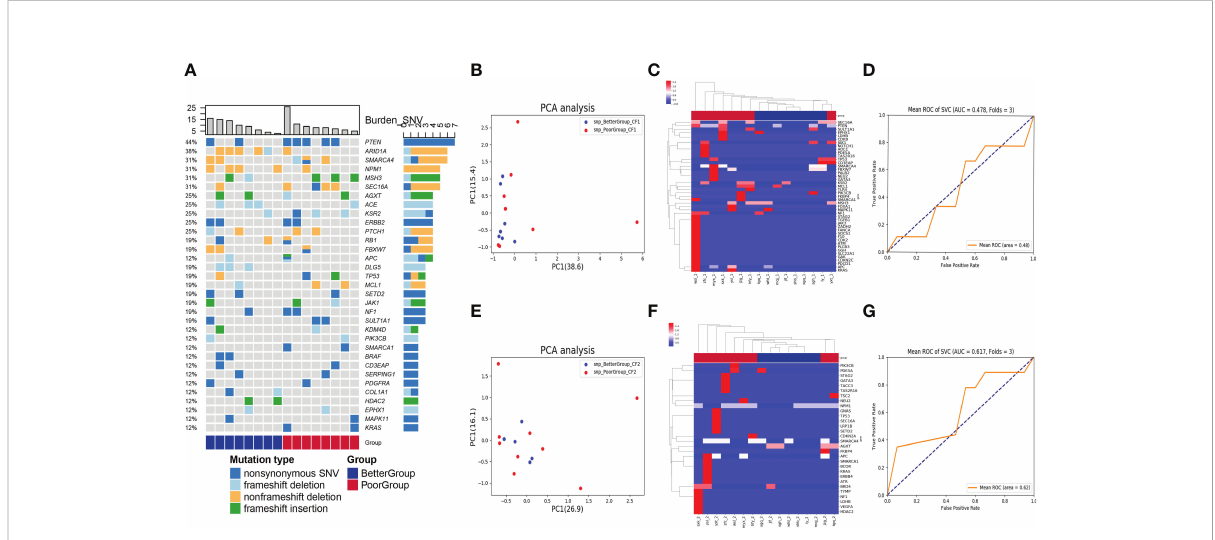
FIGURE 1 Analysis of SNV in blood samples before and after nCT on therapeutic response. (A) The heatmap showed genes with SNV detected in the baseline blood according to the frequency of occurrence from high to low. The columns represent the RC patients and the rows represent the genes. The colors on the right represent the ef fi cacy groups and mutation type. (B) The PCA dimensionality reduction and cluster analysis for SNP level in baseline blood. (C) The heatmap demonstrated the SNP level of the principal component genes in baseline blood. (D) The receiver operating characteristic curve for distinguishing the ef fi cacy groups in baseline blood (AUC = 0.48). (E) The PCA dimensionality reduction and cluster analysis for SNP level in the blood after nCT. (F) The heatmap demonstrated the SNP level of the principal component genes in the blood after nCT. (G) The receiver operating characteristic curve for distinguishing the ef fi cacy groups in blood after nCT (AUC =